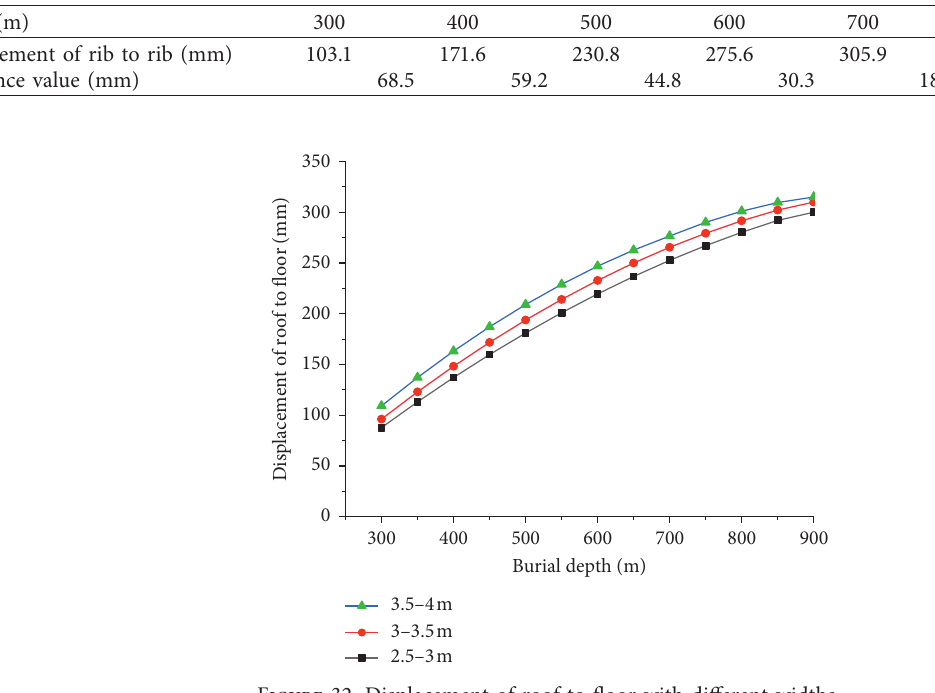
Table 6: Comparison of displacement of new digging roadway ribs (mudstone).